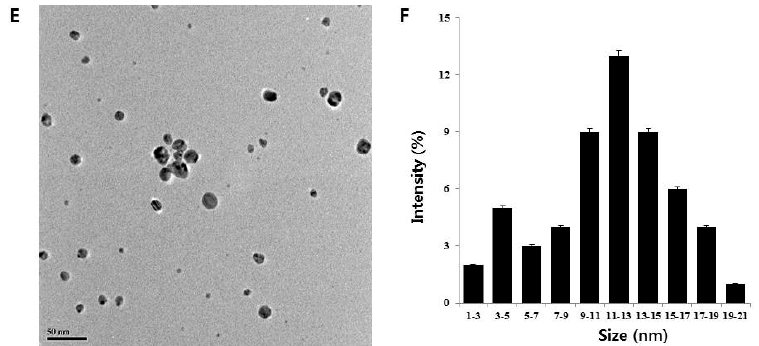
Figure 1. Synthesis and characterization of silver nanoparticles (AgNPs) using quercetin: ( A ) absorption spectrum of AgNPs synthesized using quercetin ( B ) X-ray diffraction spectra of AgNPs; ( C ) Fourier transform infrared spectra of AgNPs; ( D ) size distribution of AgNPs based on dynamic light scattering (DLS); ( E ) TEM images of AgNPs; and ( F ) several fields were used to measure AgNPs particle size; micrograph shows AgNPs with sizes ranging from 1 to 21 nm based on TEM images. Table 1. Size and ζ potential of AgNPs in water and MHB media.